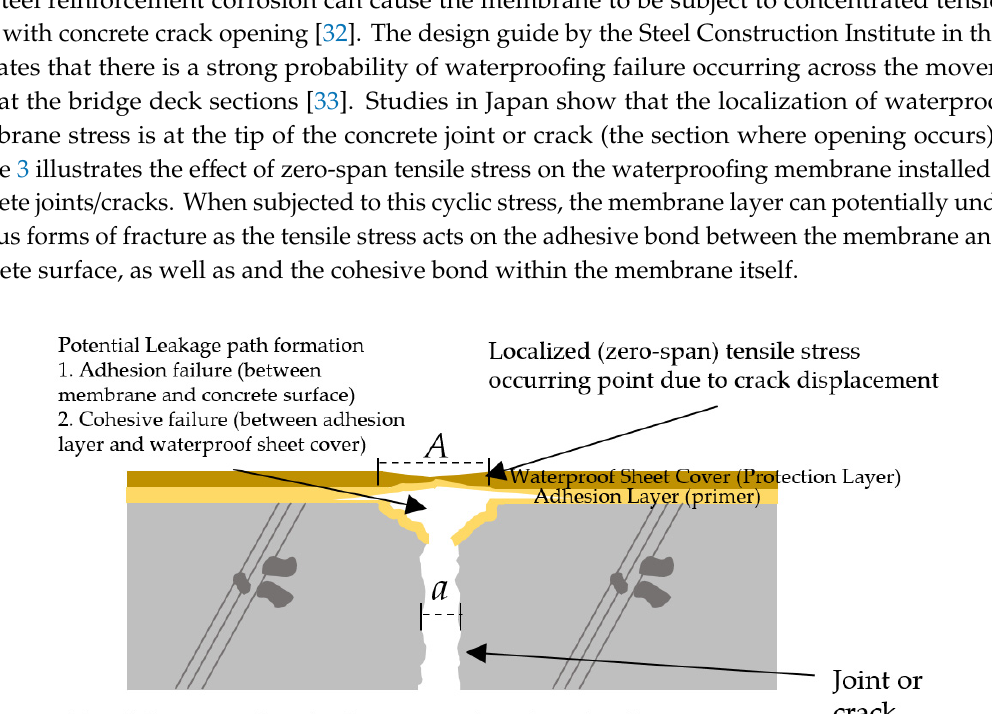
Table 4. Railway bridge design condition for finite element method (FEM) analysis.